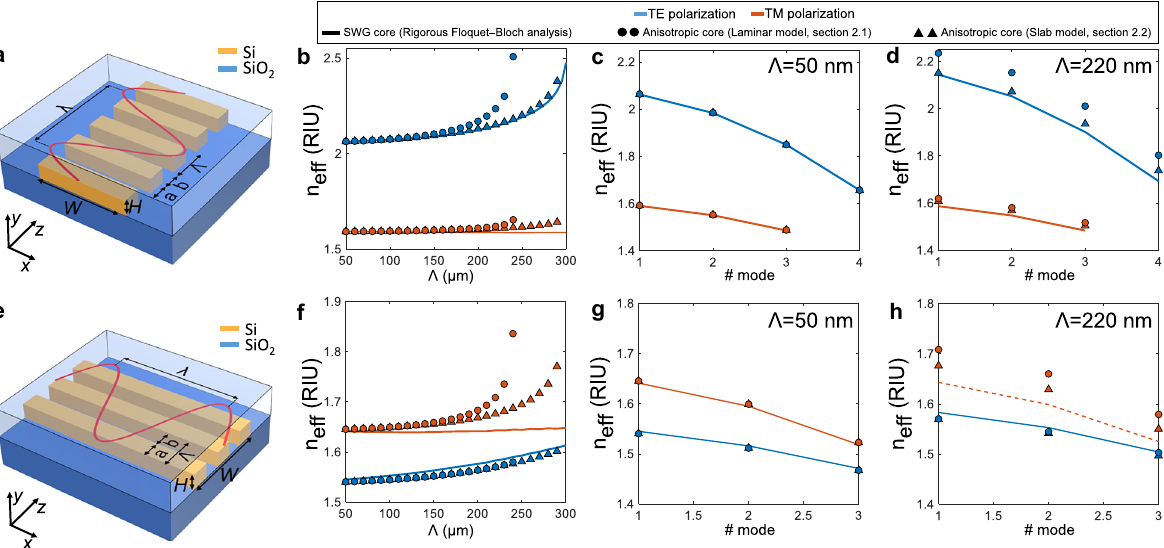
Figure4: (a)Schematicrepresentationof alongitudinalSWGwaveguide.(b) – (d)Effectiveindicesof(b)the fundamentalFloquet – Blochmode and (c), (d) higher order Floquet – Bloch modes of a longitudinal SWG waveguide calculated by rigorous 3D full-vectorial simulations (TE: Blue solid lines, TM:Orangesolid lines)comparedwith those of thecorrespondinganisotropichomogeneous-corewaveguides obtainedusingthe laminarmodel(circles)andtheslabmodel(triangles).(e)SchematicrepresentationofatransverseSWGwaveguide.(f) – (h)Effectiveindicesof (f)thefundamentalFloquet – Blochmodeand(g),(h)higherorderFloquet – BlochmodesofatransverseSWGwaveguidecalculatedbyrigorous 3D full-vectorial simulations (TE: Blue solid lines, TM: Orange solid lines) compared with those of the corresponding anisotropic homogeneous-core waveguides obtained using the laminar model (circles) and the slab model